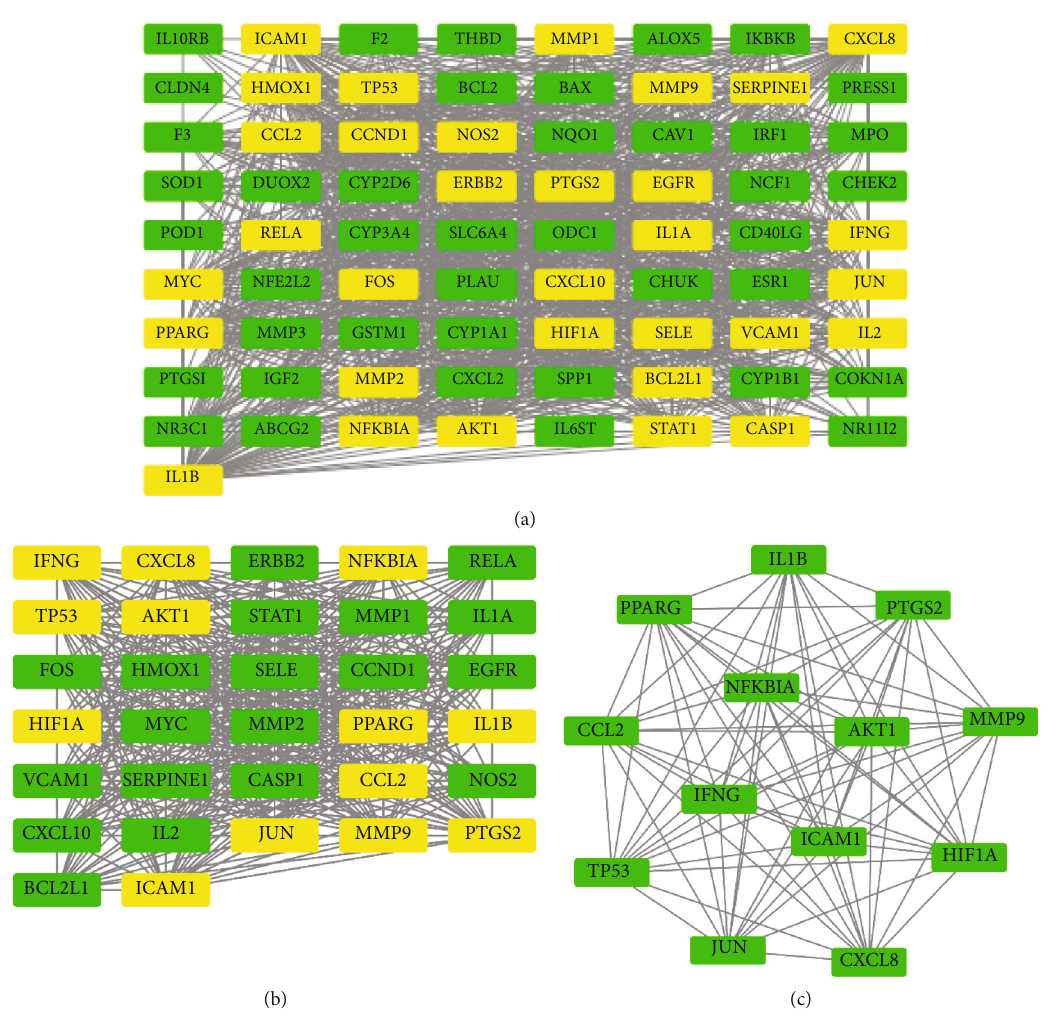
Figure 5: Process of topological screening for the PPI network. (a) PPI network from STRING visualized with Cytoscape. (b) PPI network of more signi fi cant proteins extracted from (a) by fi ltering 6 parameters: BC, CC, DC, EC, NC, and LAC. (c) Core PPI network of core targets extracted from